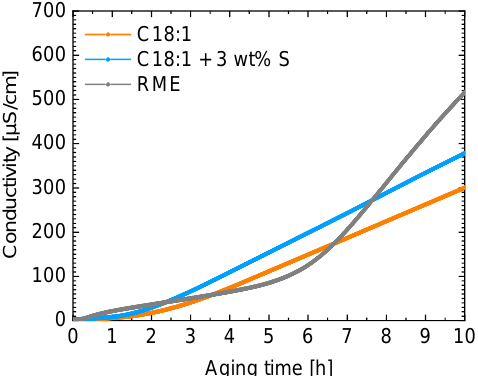
Figure 4. Conductivity of rancimat eluate. To get a first impression on the aging, the C18:1 (orange), C18:1 + 3 wt% S (blue), and RME progress were compared. Every blend of the measurement series illustrated a similar progress, which were more linear compared with common biodiesel.